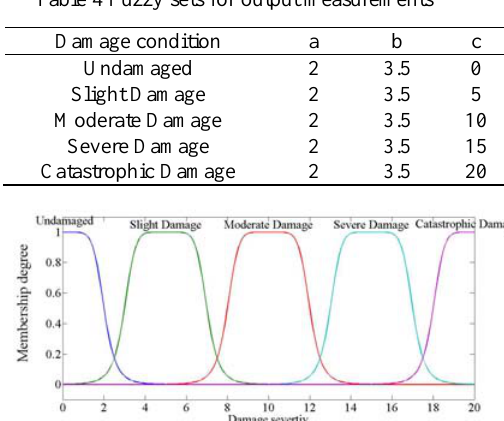
Table 4 Fuzzy sets for output measurements